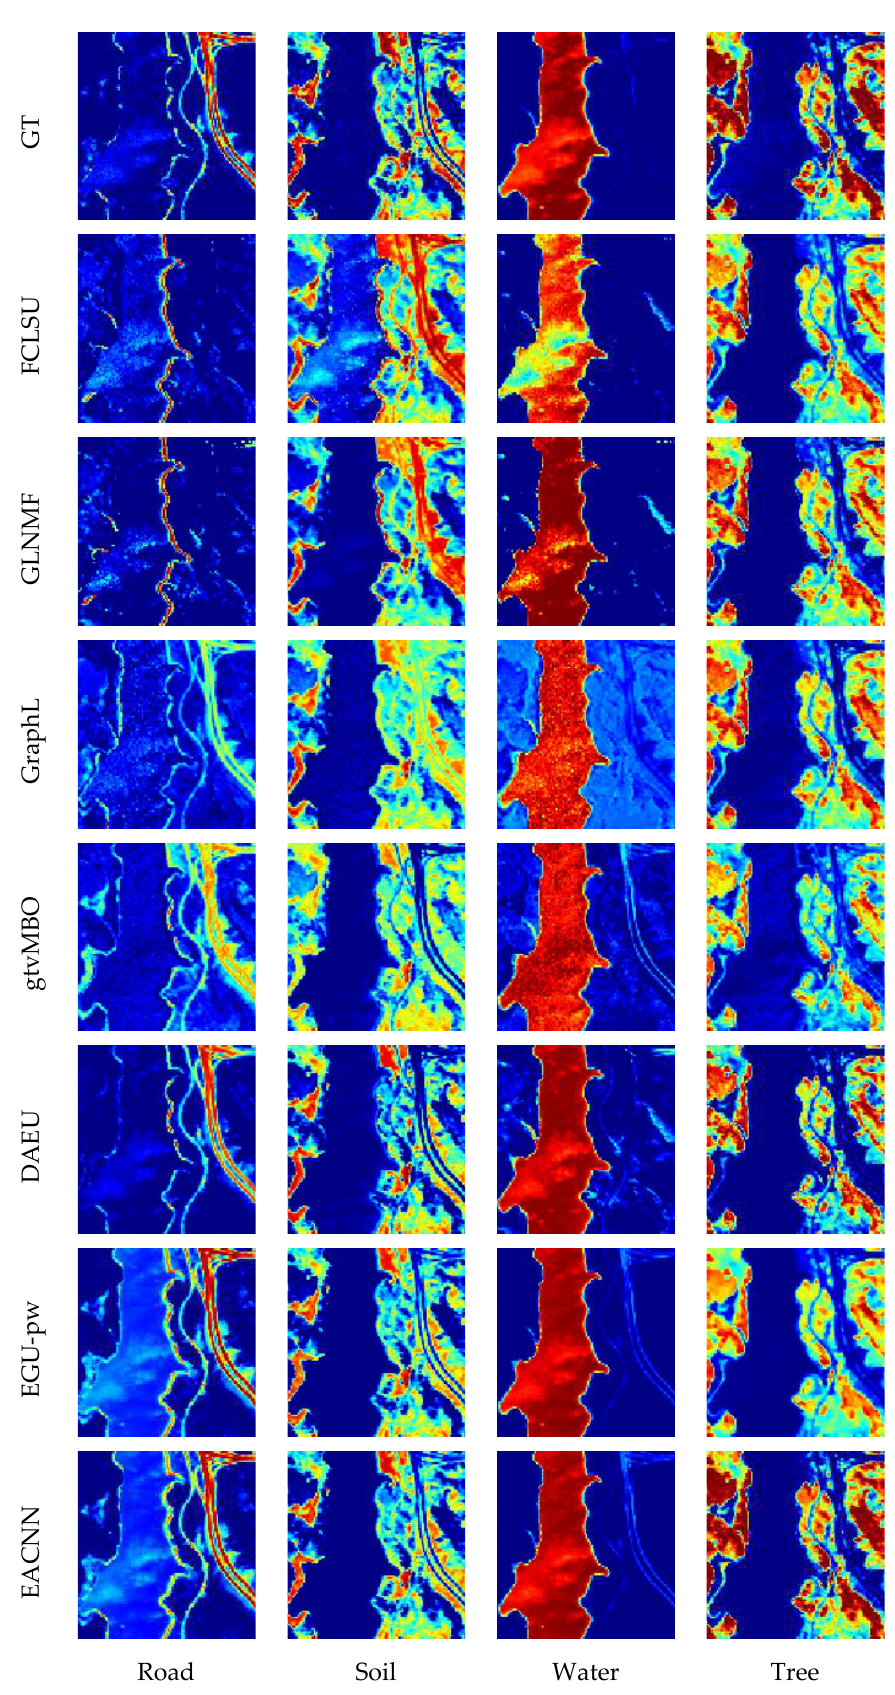
Road Soil Water Tree Figure 5. The abundance results of the Jasper Ridge dataset estimated using the proposed method.